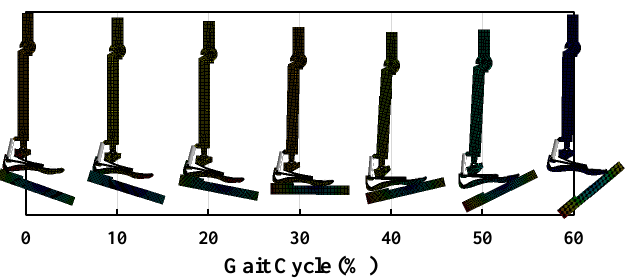
Figure 30. The lower leg prosthesis behavior when subjected to the ISO 22675 roll-over test.